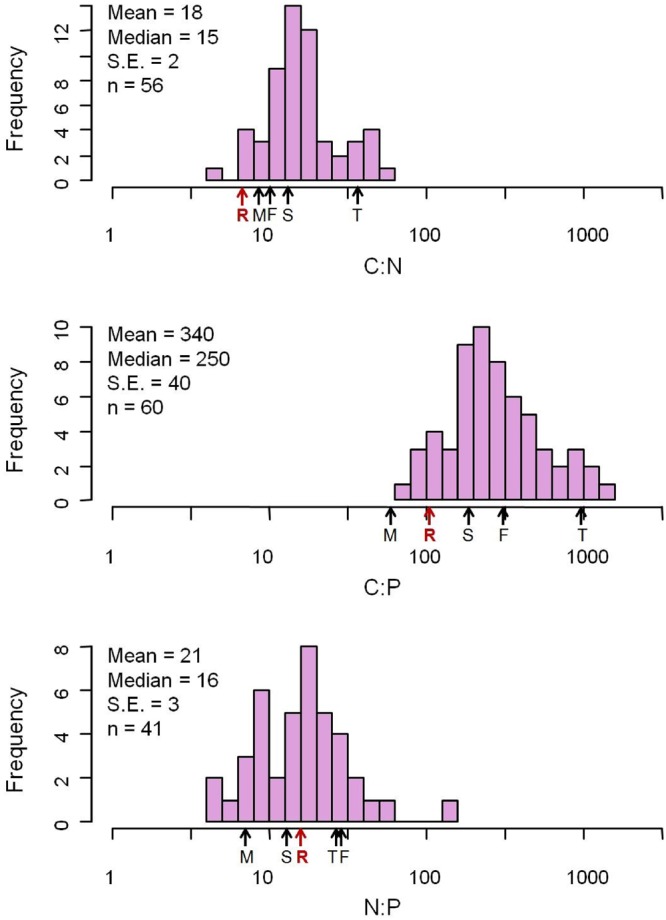
Distribution of C:N:P molar ratios from 377 fungus species. The mean C:N:P ratios for major biota and ecosystems from previous studies are marked with arrows. F, freshwater autotrophs (Elser et al., 2000a); M, soil microbial biomass (Cleveland and Liptzin, 2007); R, Redfield (Redfield, 1958); T, terrestrial autotrophs (Elser et al., 2000a); S, soil (Cleveland and Liptzin, 2007).